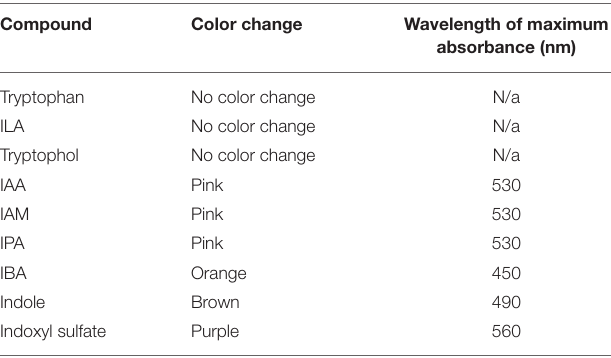
TABLE 1 | Specificity of the Salkowski reagent was determined by testing indole related compounds.